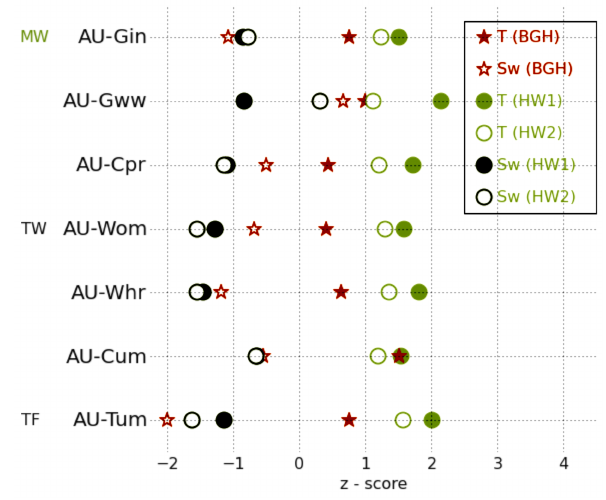
Figure 2. Z scores for temperature and soil water across flux tower sites. Solid red stars denote temperature and unfilled red stars denote soil water scores during the background period (BGH) compared to the climatological background BGC. Scores for temperature ( T ) and soil water (Sw) for HW1 and HW2 compared to the same time periods in the years 1982–2013 are shown for HW1 (1–9 January 2013) by filled dots and for HW2 (10–18 January 2013) by unfilled